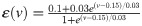
Phasic spiking with dynamic negative feedback.a) Typical trajectories in the phase plane for the ε-model (= 0.03, constant) and b) for ε(v)=0.1+0.03e(v-0.15)/0.031+e(v-0.15)/0.03. D = 0.03 in both (a) & b). c) Comparison of the power spectrum of v(t) with D = 0.03 for both curves. d) Comparison of the firing rates ν as a function of D. Throughout we define ν = 〈y(t)〉 where y(t) = ∑i
δ(t − ti) and ti is the time of the ith trajectory crossing of w = wc from below (wc = 0.14 for ε(v)-model and wc = 0.15 for the ε-model).